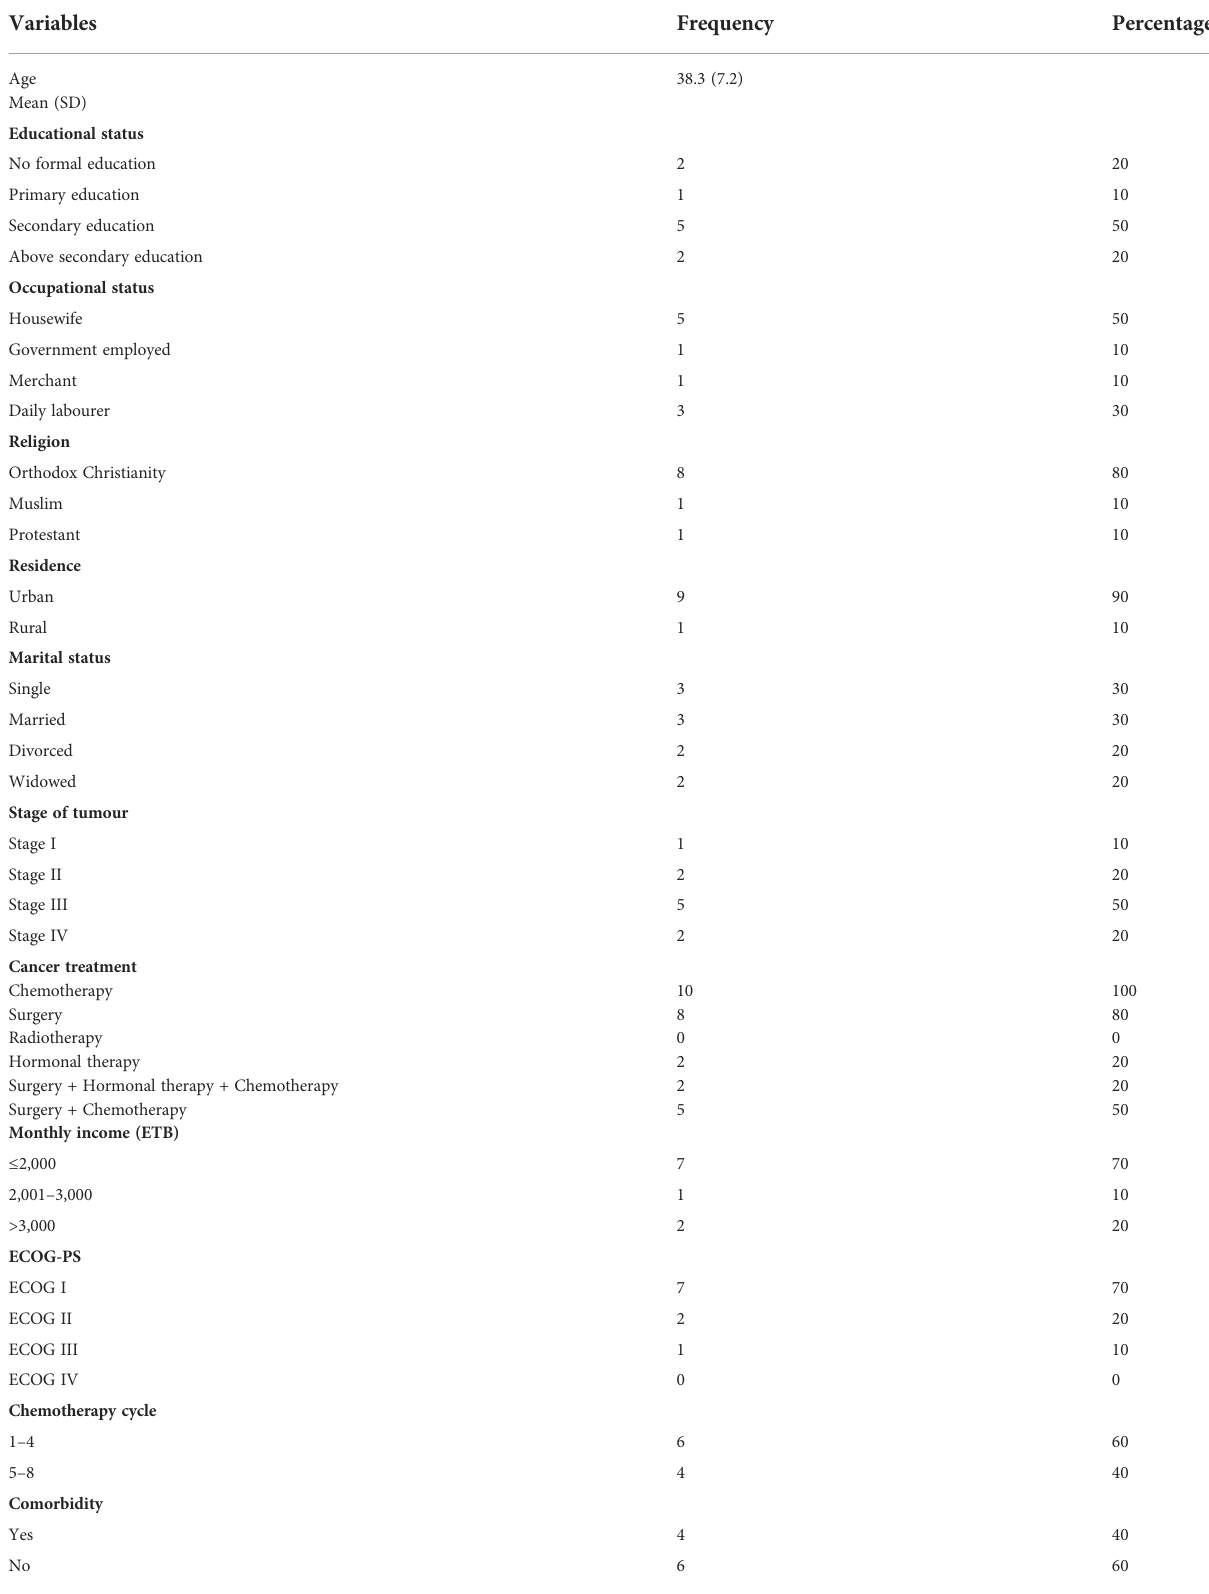
TABLE 2 Baseline sociodemographic and clinical characteristics of breast cancer patients undergoing